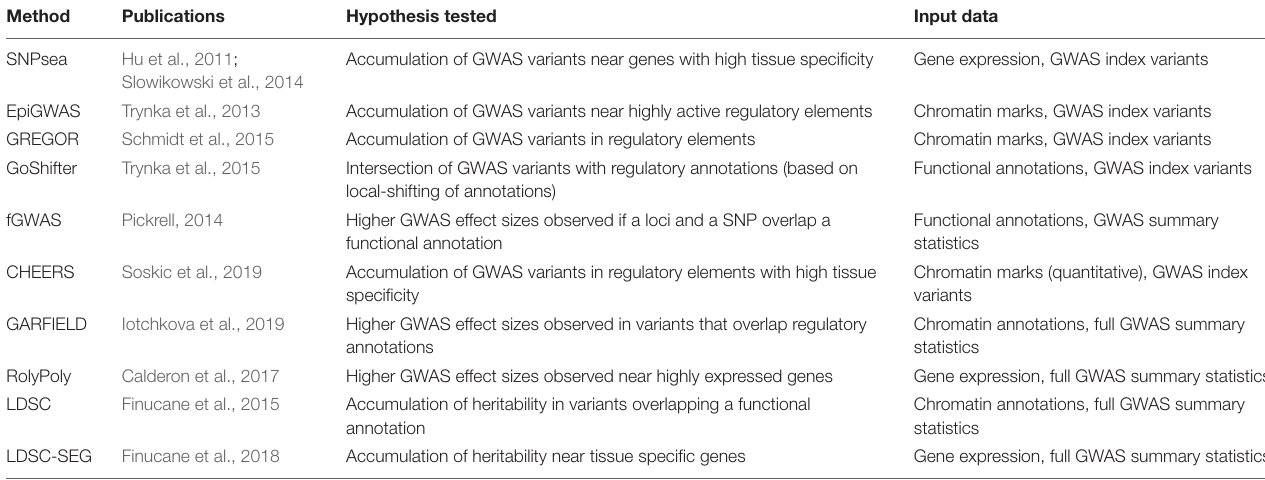
TABLE 1 | Methods for SNP enrichment